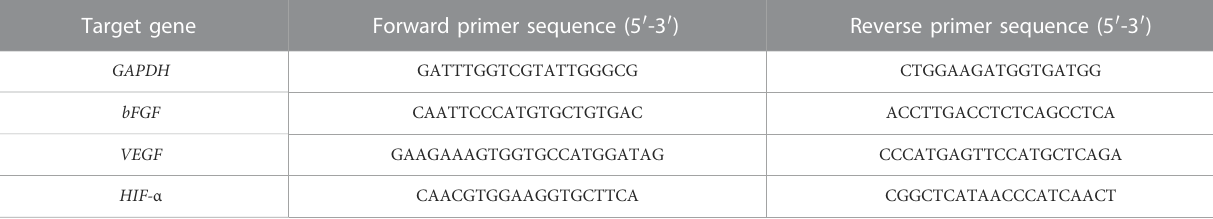
TABLE 1 Primers for gene expression analysis. Target